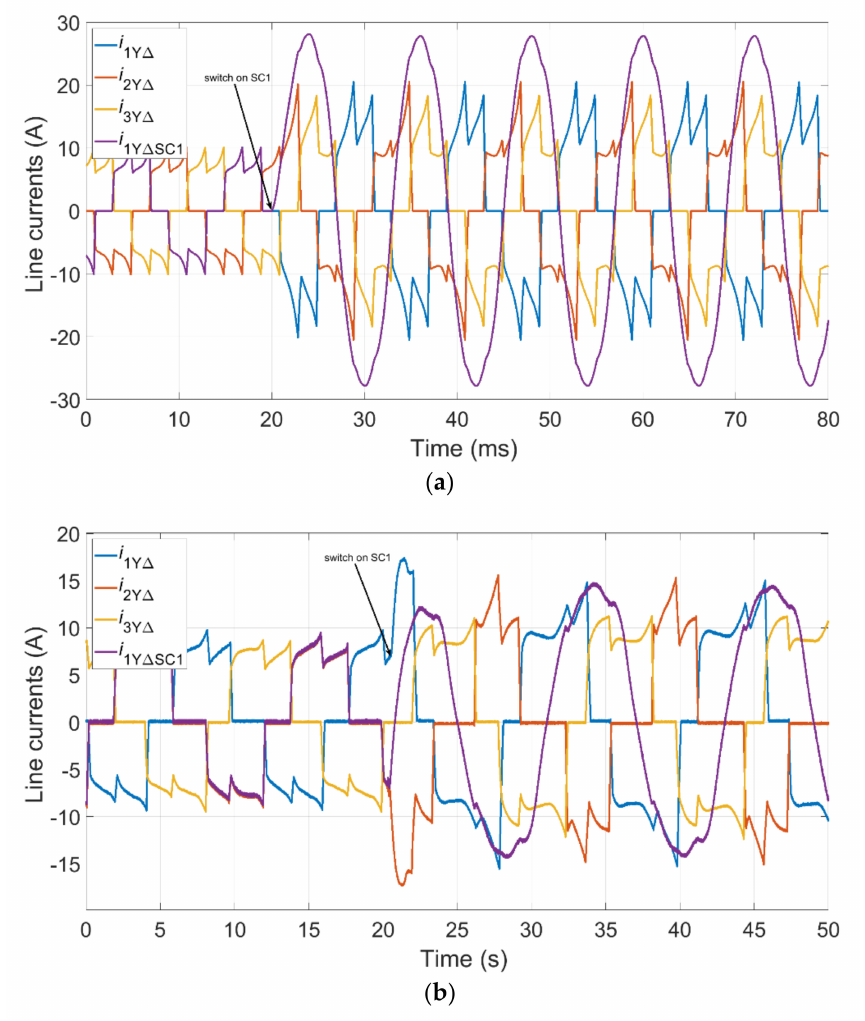
Figure 13. Y (cid:52) configuration—waveforms of line currents—healthy to SC1: ( a ) numerical calculations, ( b ) laboratory